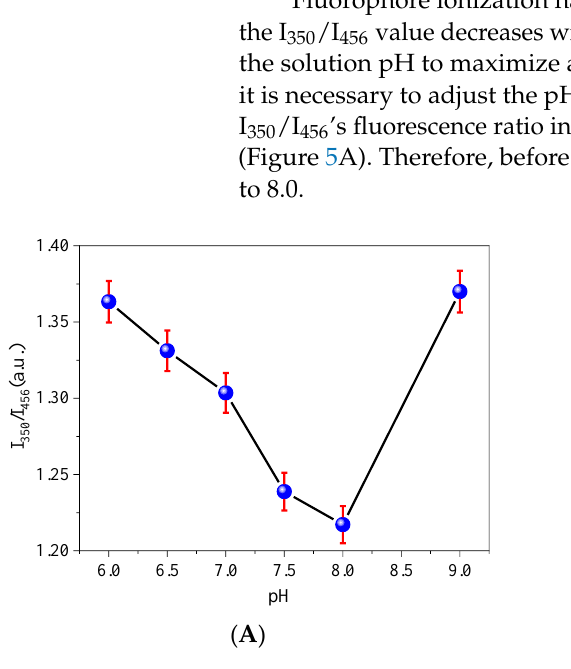
Figure 5. Effect of ( A ) pH under the same conditions (system temperature: 44 °C; N-CDs: 100 µL; MOR concentration: 10 μg/mL; Ex: 310 nm; Em: 350 nm and 456 nm) and ( B ) system temperature under the same conditions (pH: 8.0; N-CDs: 100 μL; MOR concentration: 10 μg/mL; Ex: 310 nm; Em: 350 nm and 456 nm).